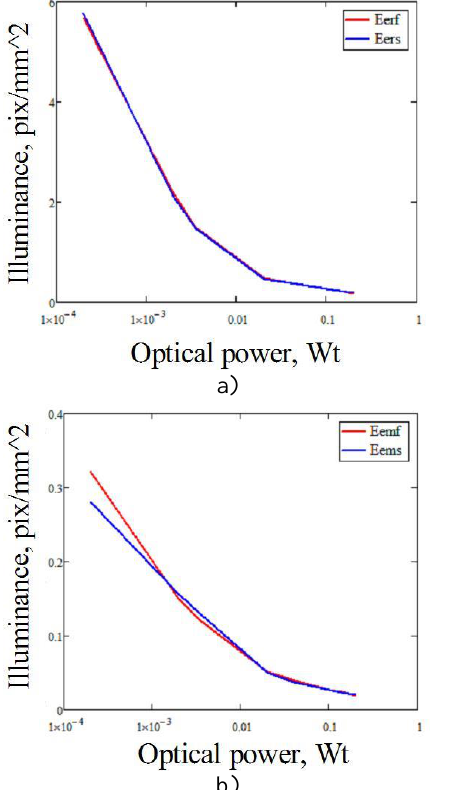
Fig. 8. Relative illuminance of the photometric image in the scattered light for human shoulder tissues (blue line) and finger (red line), depending on the power of incident light